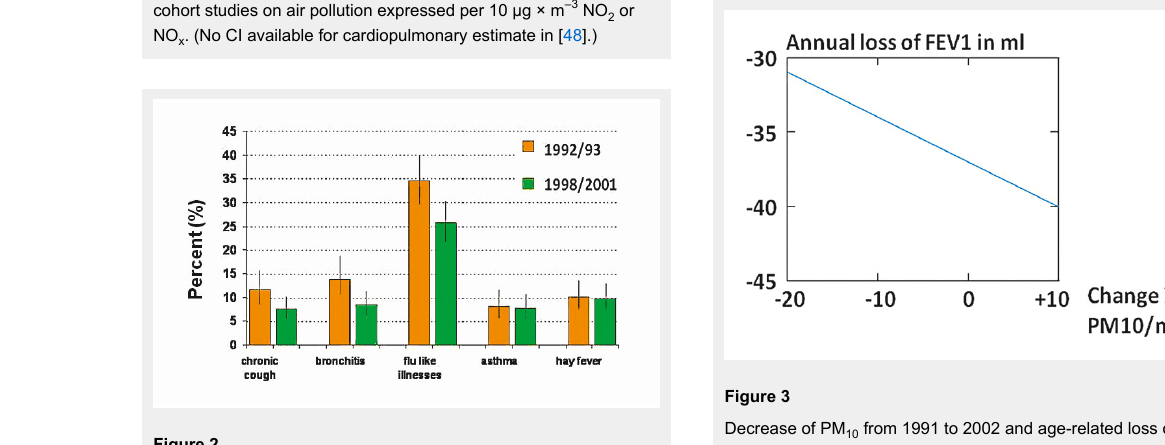
Prevalence of respiratory illnesses in Swiss schoolchildren after the improvement of air quality in the nineties, SCARPOL Study [17].